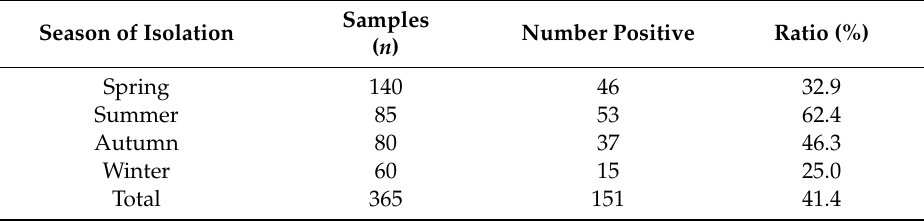
Table 1. Prevalence of Salmonella isolated from duck meats at retail markets in Southern